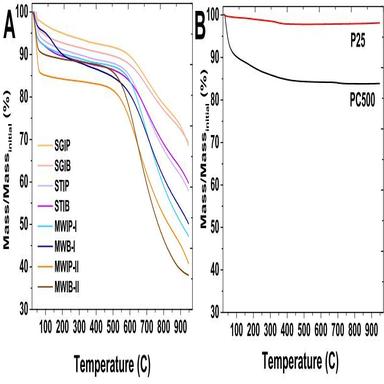
TGA thermograms (A) of the TiO2/AC heterostructures and (B) pristine P25 and PC500.